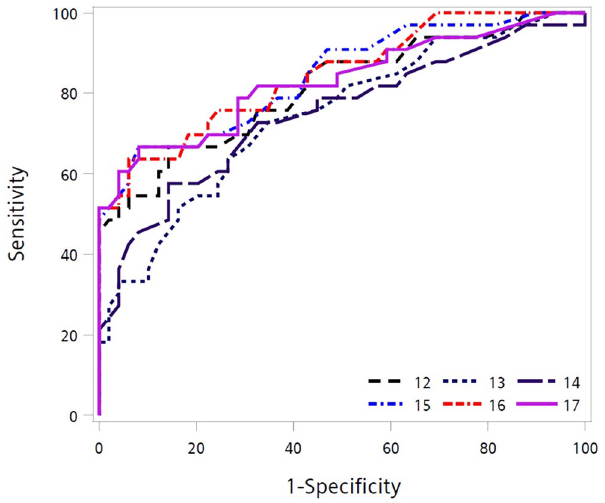
Figure 1. ROCs for three- and four-gene models; Model 12: MDM2/RNF4/WEE1; Model 13: DUSP6/MDM2/ WEE1; Model 14: DUSP6/MDM2/RNF4; Model 15: DUSP6/RNF4/WEE1; Model 16: DUSP6/MDM2/RNF4/